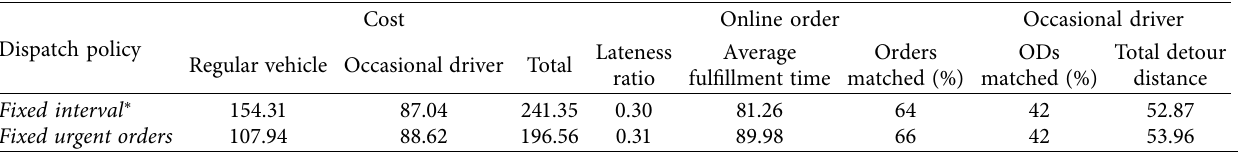
Table 8: Comparison of regular vehicle dispatch policies.